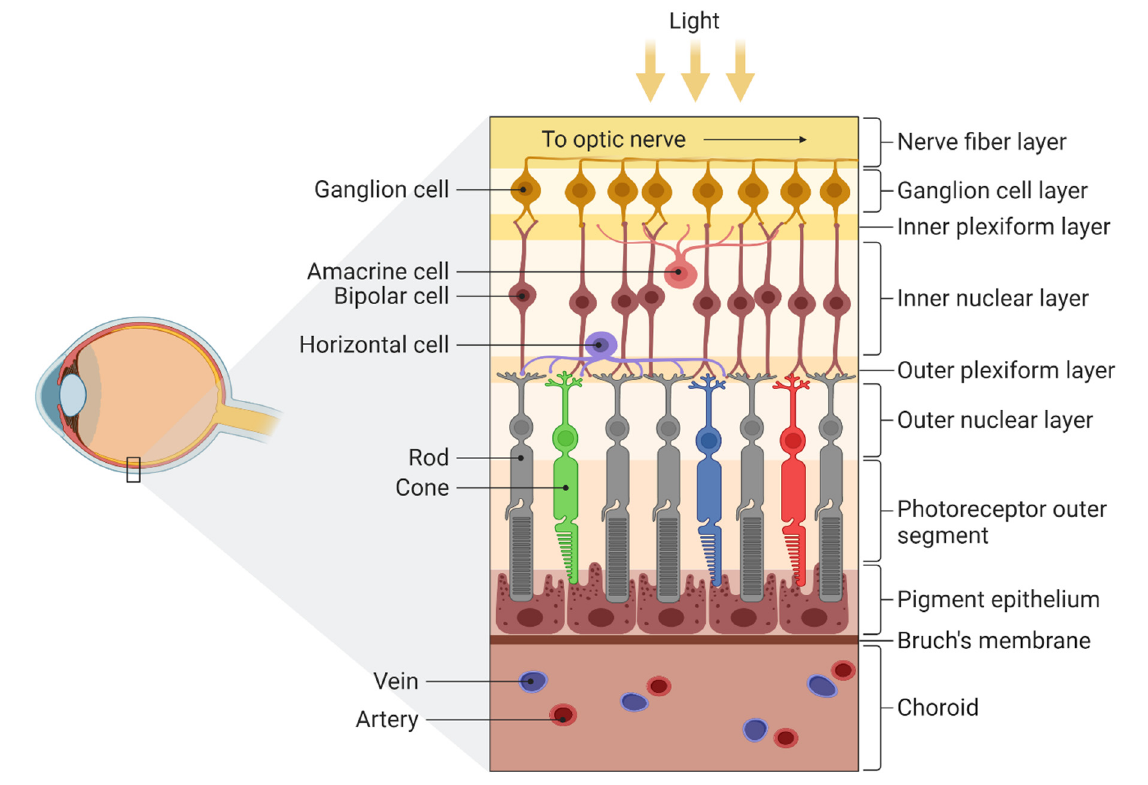
Figure 1. Structure of the retina. There are four main layers: (1) pigment epithelium, (2) the light- sensitive cells such as rods and cones that transmit information to a layer of neurons called (3) bipolar cells which are connected to (4) ganglion cells, located directly under the optic nerve. For more detailed information see Mahabadi & Khalili [29]. Adapted from “Structure of the Retina”, by BioRender.com (2022). Retrieved from https://app.biorender.com/biorender-templates, accessed on 9 September